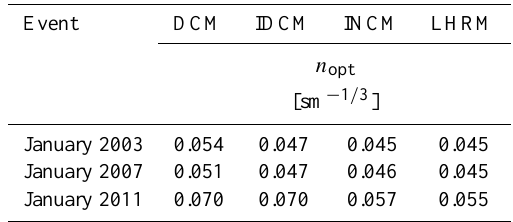
Table 5. Optimum roughness coefficient, n opt , for the three flood events.